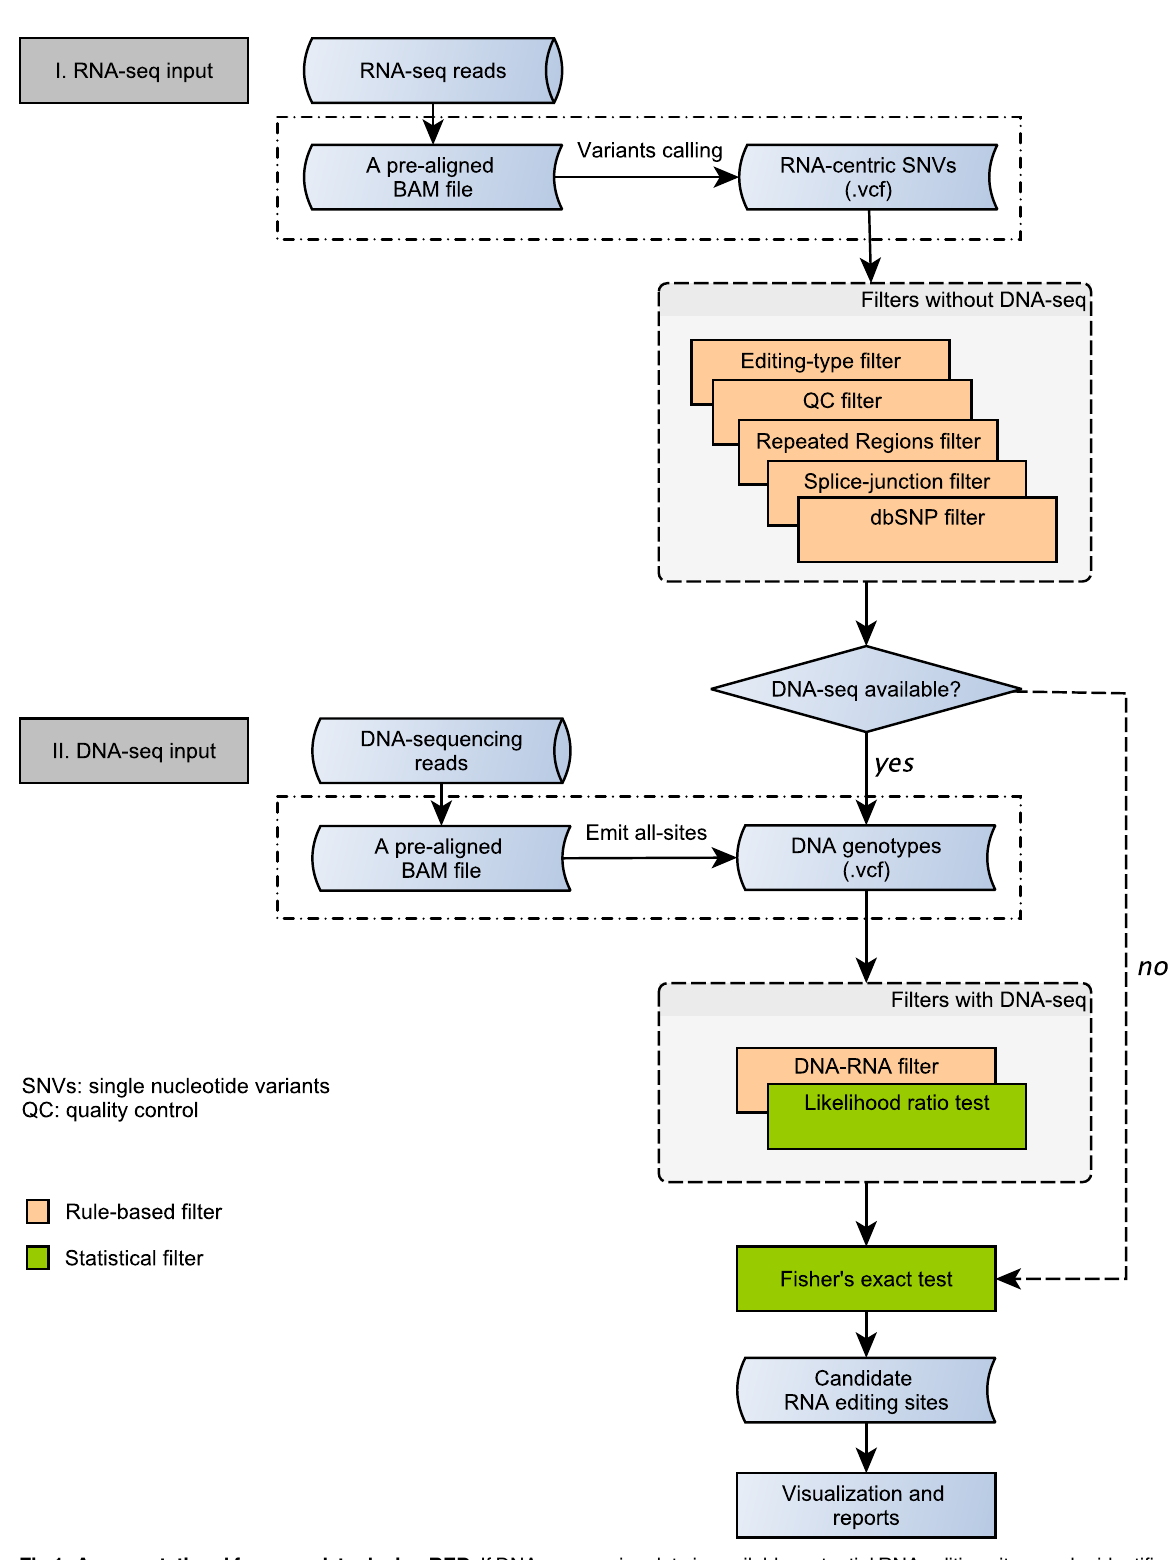
Fig 1. A computational framework to design RED. If DNA-sequencing data is available, potential RNA-editing sites can be identified by DNA-RNA mode; otherwise by de novo mode. Rule- and statistical-based filters were integrated in the framework.